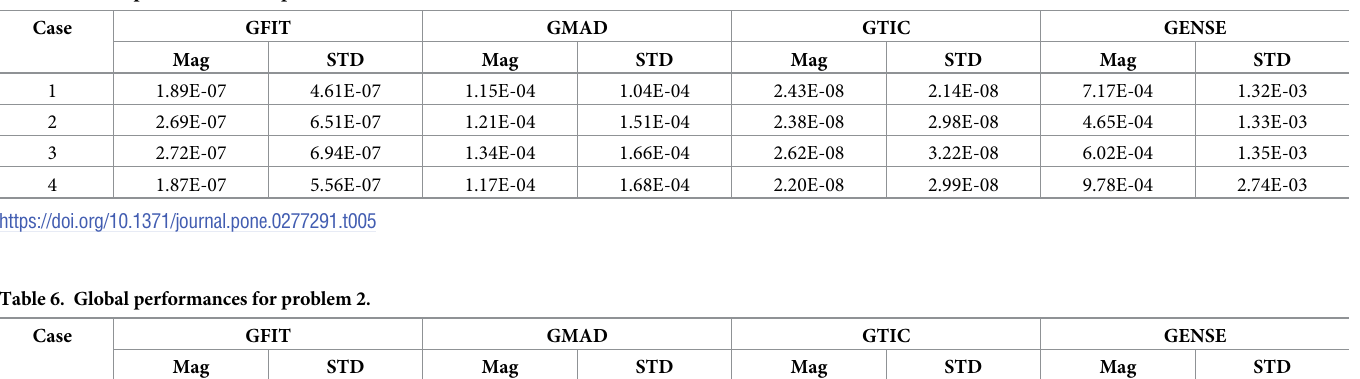
Table 5. Global performances for problem 1.